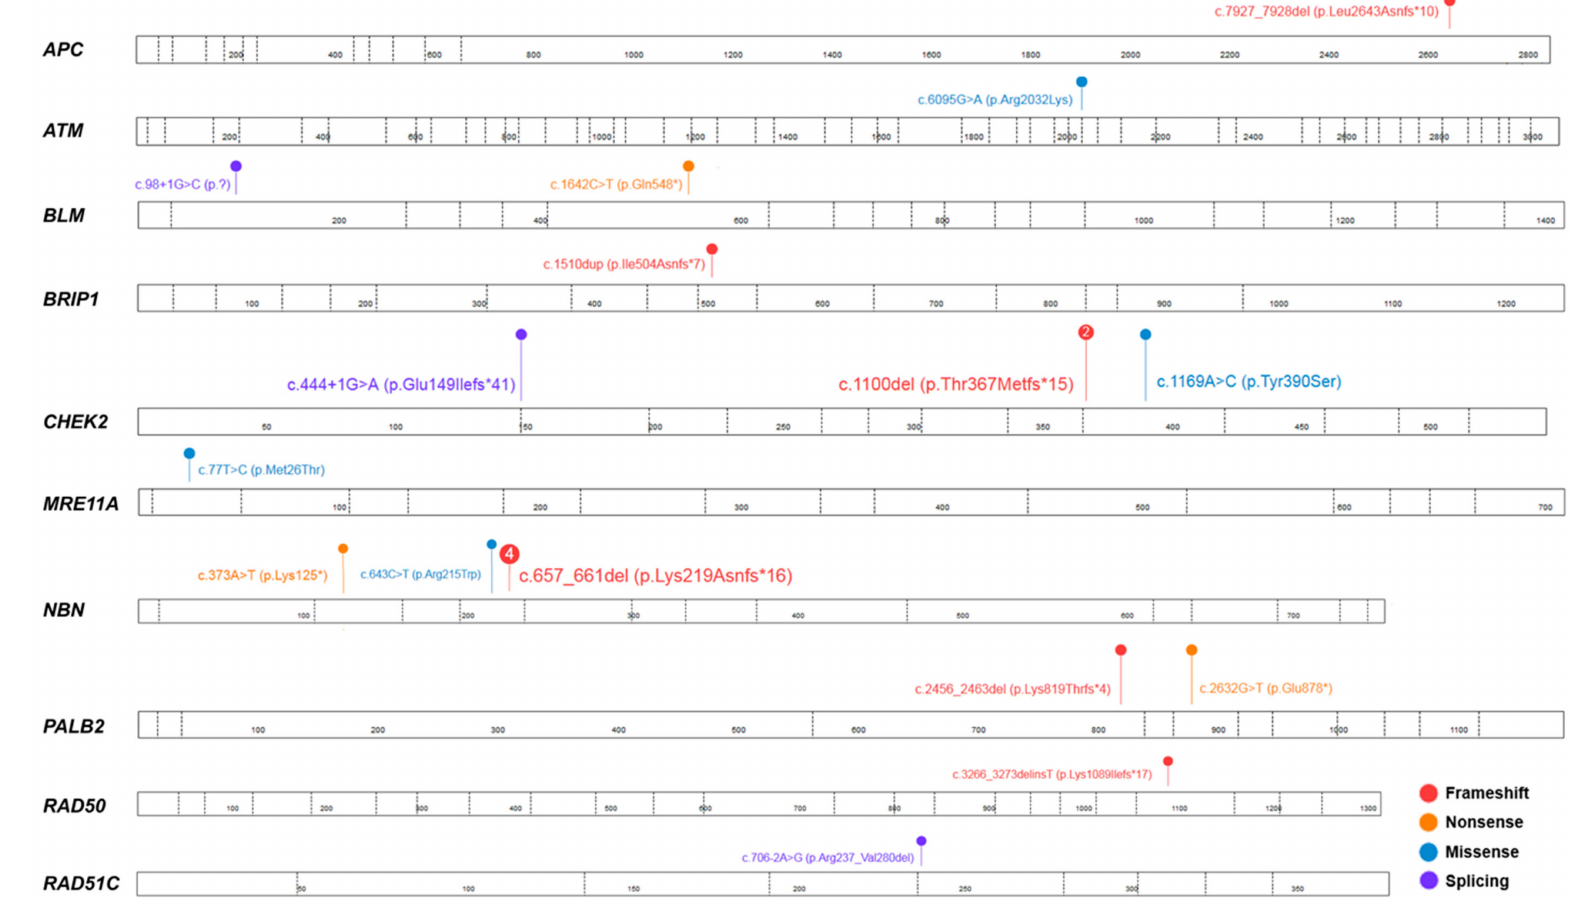
Figure 2. Spectrum of the pathogenic or likely pathogenic variants identified in moderate- and low-penetrance genes in the studied cohort of 333 unselected ovarian cancer individuals. Each number in circle corresponds with the total number of individuals heterozygous for a specific variant. The figure was prepared using the ProteinPaint application